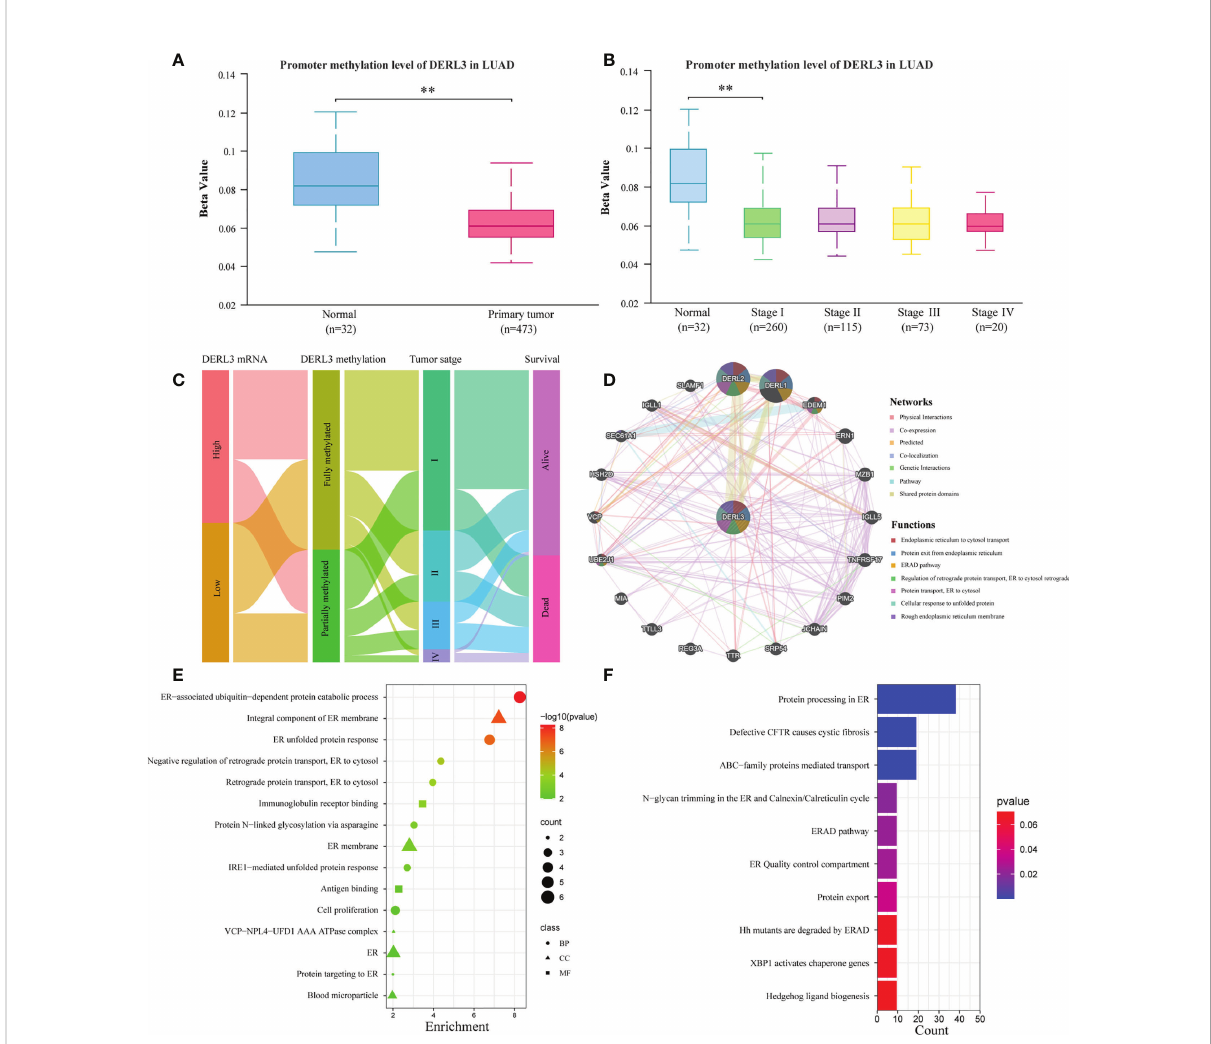
FIGURE 2 Promoter methylation and functional annotation of DERL3 in LUAD patients. (A) The differential methylation of the DERL3 promoter in primary LUAD tumors. (B) The correlation between DERL3 promoter methylation and clinical stage of LUAD patients. (C) Sankey diagram visualization of relationships between DERL3 mRNA expression, methylation, tumor stage, and survival. (D) DERL3 co-expression network constructed by GeneMANIA. (E, F) GO and KEGG enrichment analysis of DERL3 co-expression molecules. (**p <